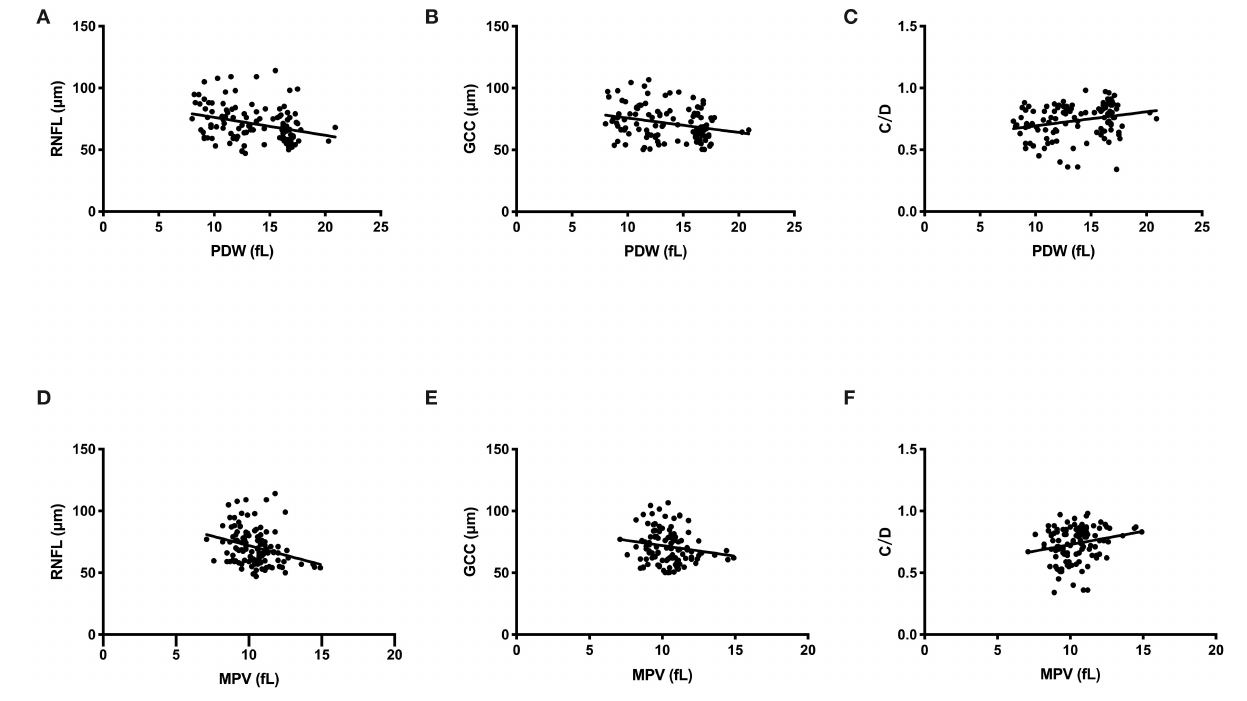
FIGURE 2 | Scatterplot of patient individual measurements for platelet parameters and optical coherence tomography (OCT) parameters. Each data point represents one patient. Linear regression is displayed. (A) PDW and RNFL thickness. (B) PDW and GCC thickness. (C) PDW and C/D. (D) MPV and RNFL thickness. (E) MPV and GCC thickness. (F) MPV and C/D. PDW, platelet distribution width; MPV, mean platelet volume; RNFL, retinal nerve fiber layer; GCC, ganglion cell complex; C/D, cup/disc area